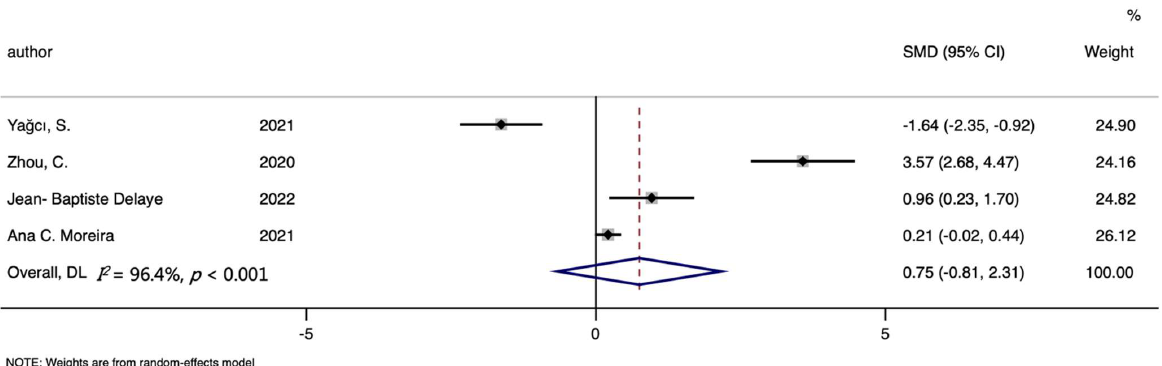
Figure 9. Forest plot of standard mean difference (SMD) with corresponding 95% confidence intervals (CIs) of studies [10,18,20,24] on hepcidin levels in COVID-19 cases and controls. The solid diamond and horizontal line represent the study-specific effect and 95%CI, respectively; the size of the grey square is positively correlated with the weight distributed to each study in the meta-analysis. The center of open diamond with the vertical dashed line expresses the pooled SMD, and the width expresses the pooled 95%CI.